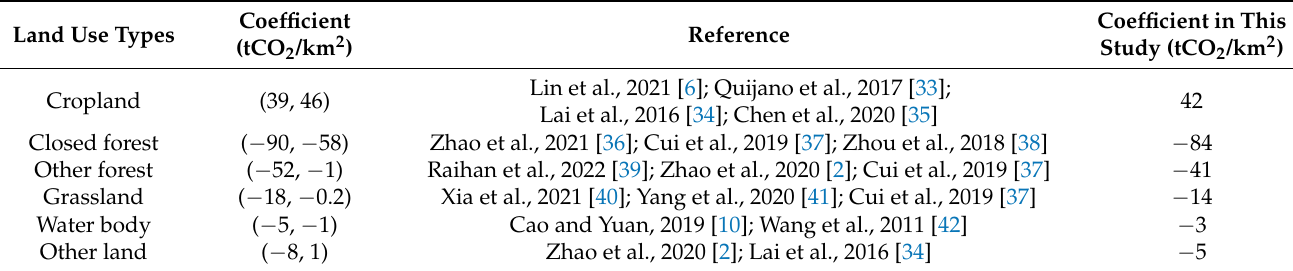
Table 1. Carbon emission coefficients of various land-use